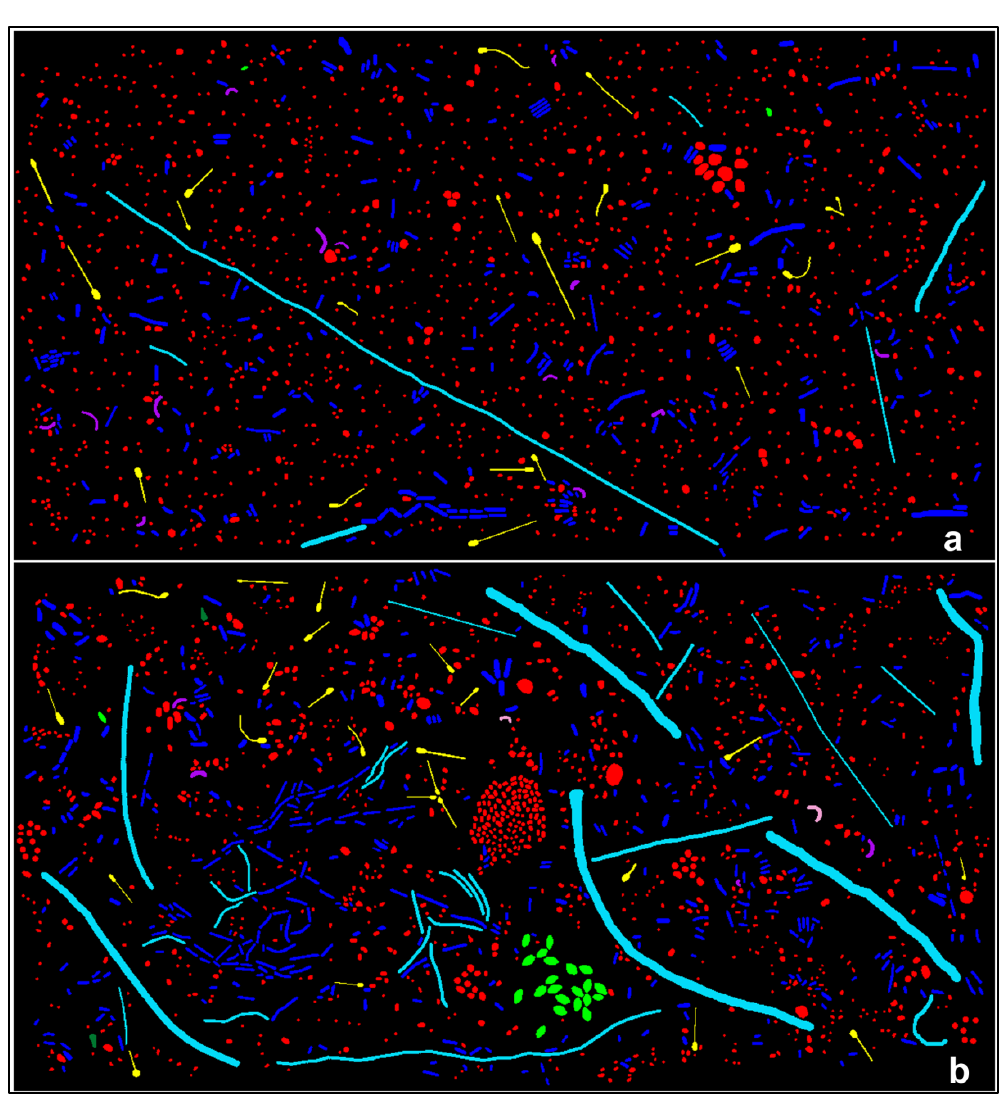
Figure 2. CMEIAS-rendered pseudocolor images indicating the morphotype classification for each individual microbe in situ within biofilm assemblages of communities A ( a ) and B ( b ). See text for details.